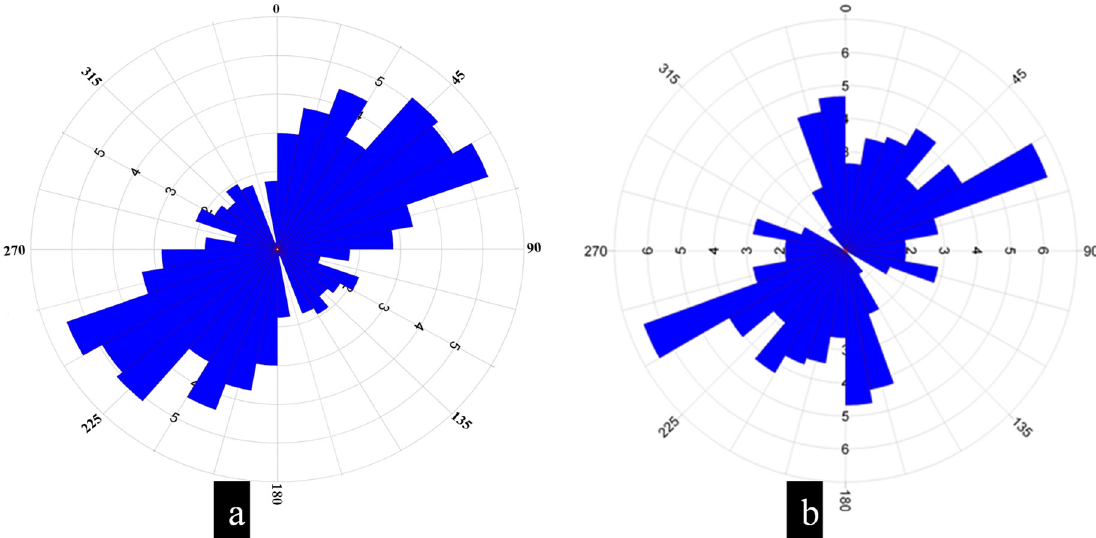
Figure 8. Lineament maps extracted from ( a ) SF and IL and ( b ) the GIS results.